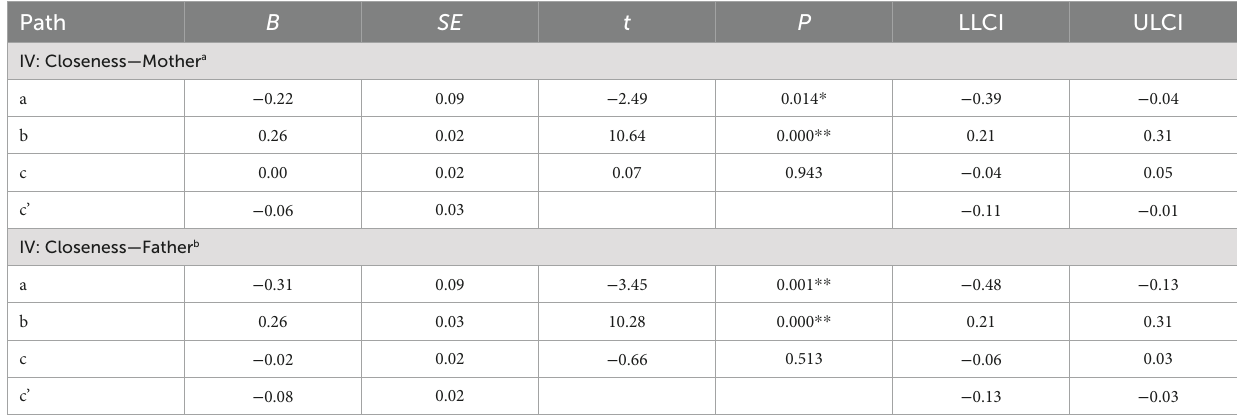
TABLE 2 Mediation